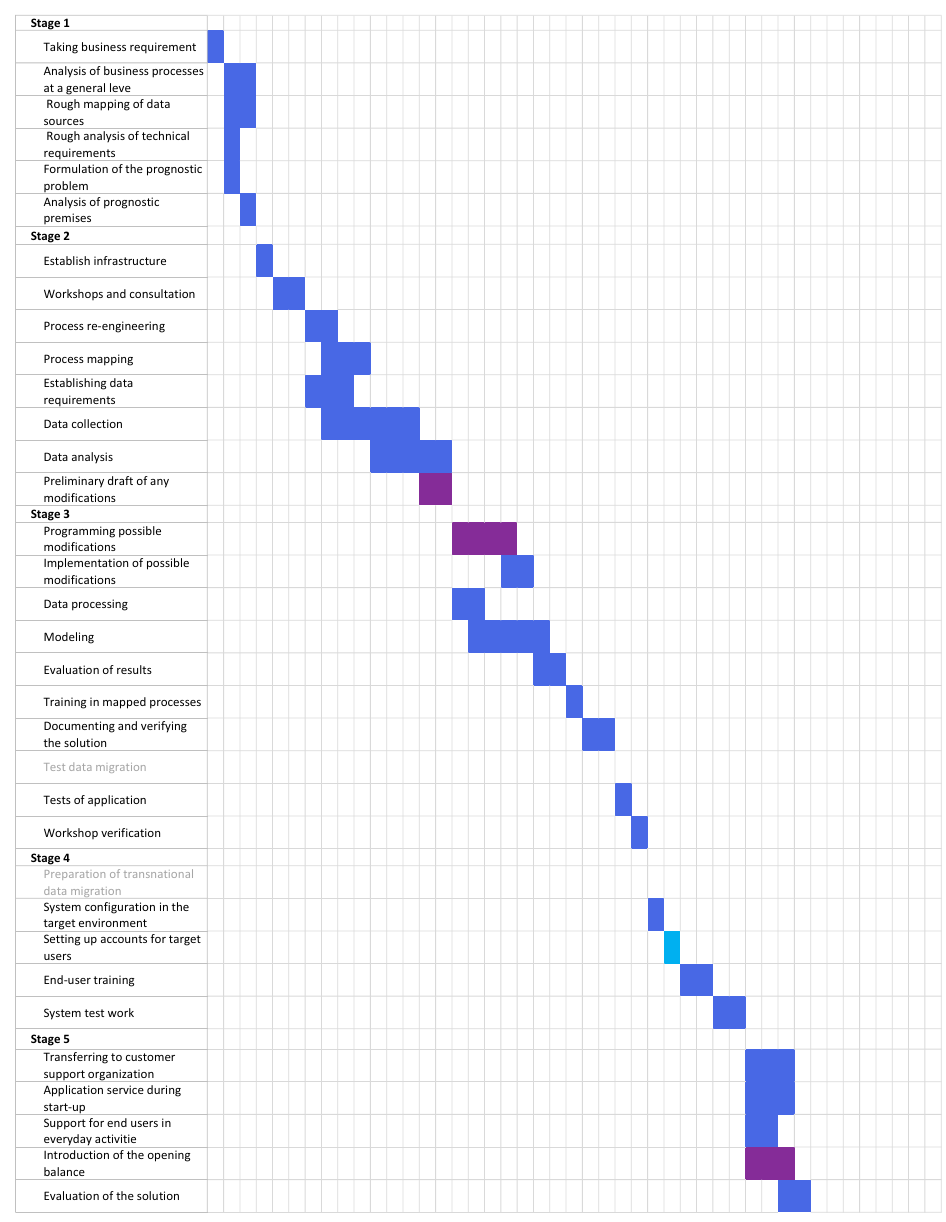
Figure 6. The distribution of work in the new methodology. High-risk work is highlighted in purple. Compared to the execution times of the classic methodology, the execution times of stages 2 and 3 are longer, but stages 4 and 5 are shorter. In that case, migration of full sample of data take place in the second stage, so we do not have test data migration task in stage 3 and preparation of transaction data task in stage